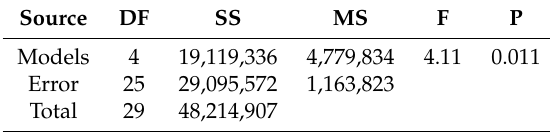
Table 6. ANOVA: scrap (m) vs. die-nozzle